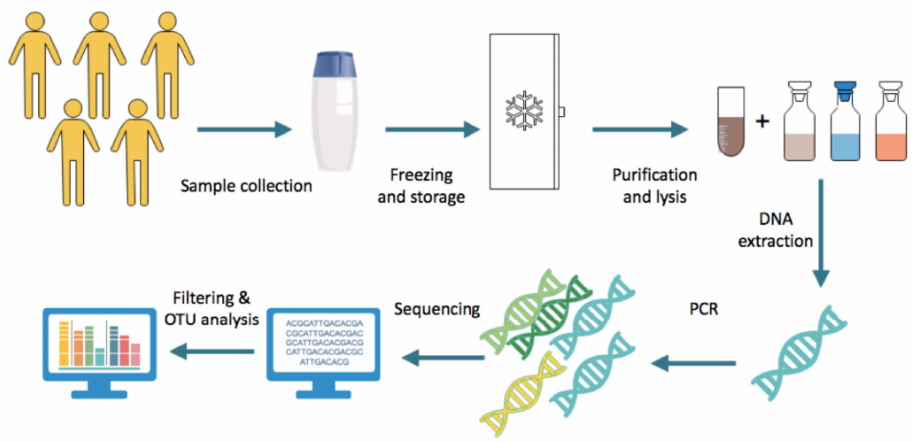
Figure 2. Steps generally undertaken in stool microbiome